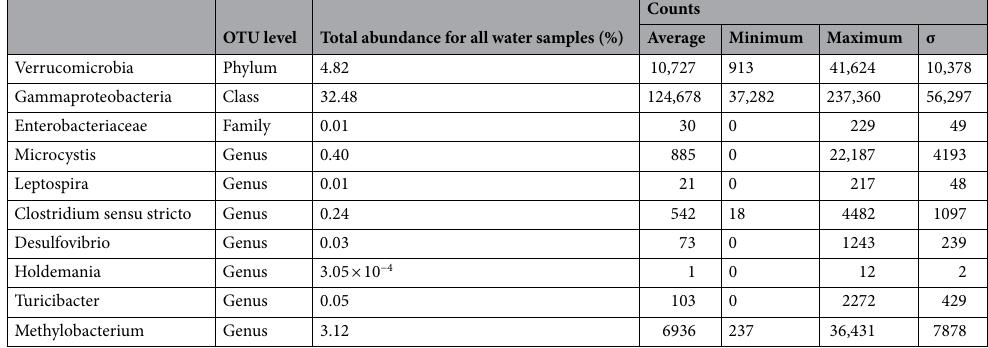
Table 2. Total abundance of bacteria for all samples shown as a percentage of the total microbial count in all samples, operational taxonomic unit (OTU) level and sample average, minimum, maximum and standard deviations values of microbial counts of microbes in water samples from this study. Table shows the current study’s results for microbes previously identified 37–39 in higher concentrations in CKD compared to healthy individuals.